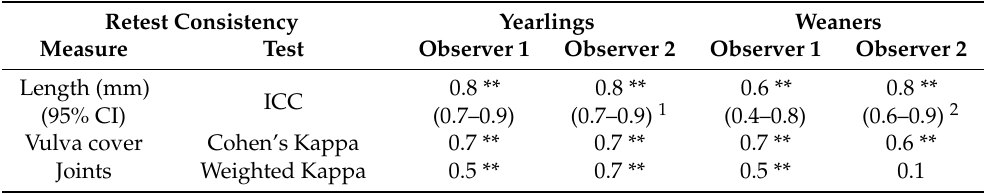
Table 3. Retest consistency coefficients for each measurement method for ( n = 51) and weaners ( n = 48), significance at the p < 0.01 level indicated by